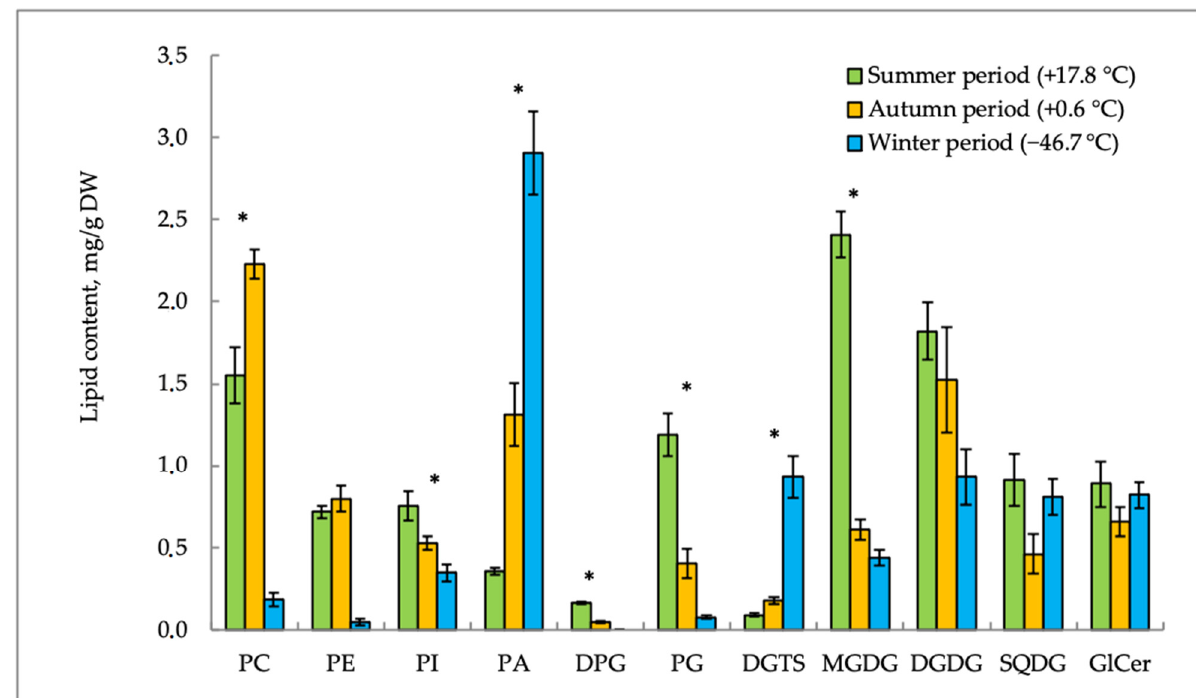
Figure 3. Seasonal changes in the content of individual lipid classes in E. scirpoides shoots. PC—phosphatidylcholine; PI—phosphatidylinositol; PE—phosphatidylethanolamine; PG—phosphatidylglycerol; PA—phosphatidic acid; DPG—diphosphatidylglycerol; GlCer—glycoceramide, DGDG—digalactosyldiglyceride, DGTS— O -(1,2-diacylglycero)- N , N , N -trimethylhomoserine, MGDG—monogalactosyldiglyceride, SQDG—sulfoquinovosyldiacylglycerol. Data are shown as the mean ± SD ( n = 3); * significant differences according to Student’s t -test. Table 1. Seasonal changes in the FA composition of lipids in shoots of Equisetum variegatum growing at the Pole of Cold. Summer Period (+17.8 °C *) Autumn Period (+0.6 °C *) Winter Period ( − 46.7 °C *) Fatty Acids